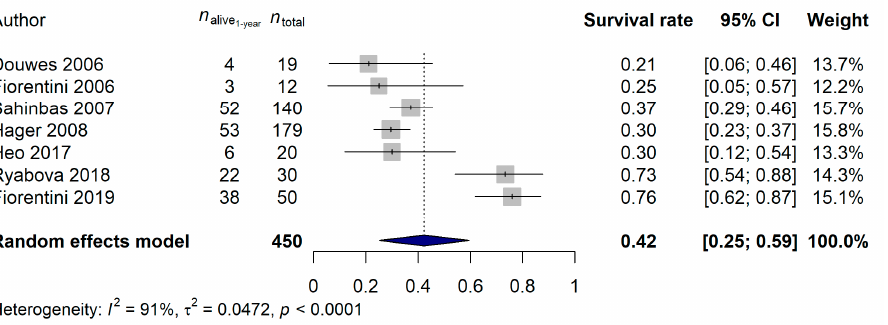
Figure 2. Effect of modulated electro-hyperthermia on 1-year glioblastoma survival rate [43,46–51].